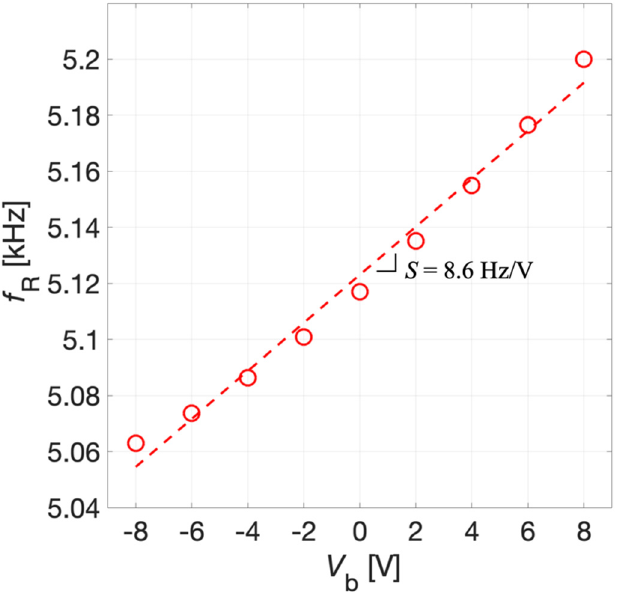
Figure 10. Simulation results of the resonant frequency f R of the first eigenmode of the diaphragm as a function of the bias voltage V b .